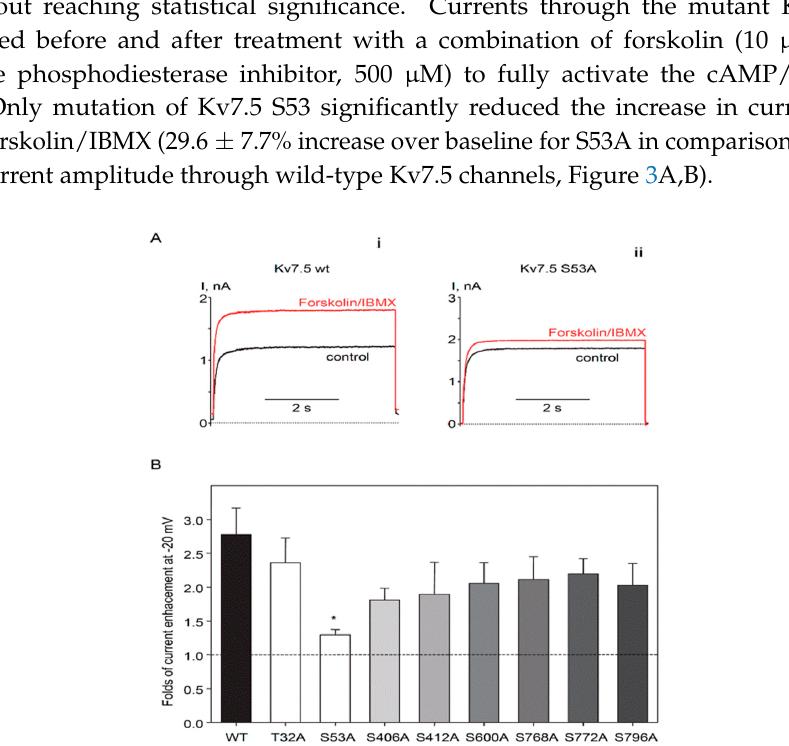
Kv7.5S600A ( n = 6), Kv7.5S768A ( n = 6), Kv7.5S772A ( n = 6), Kv7.5S796A ( n = 4). White bars represent N-terminal mutant, grey bars of different shades represent C-terminal mutants. * Significant difference from wild-type ( p = 0.03, One Way ANOVA on